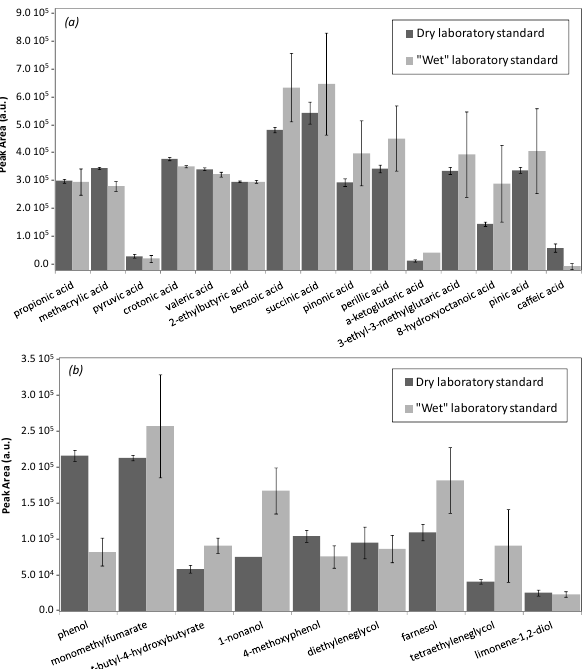
Fig. 9. Comparison of in-solution and on-Tenax TA carboxyl/hydroxyl compound MTBSTFA-derivatisation: (a) carboxylic acids derivatisation results, (b) hydroxyl compounds derivatisation results. “Peak Area” refers to FID chromatogram, in area units. Error bars represent ± one standard deviation determined from three replicates for on-Tenax TA derivatisation and from two replicates for in-solution derivatisation (no error bar indicates only one replicate).